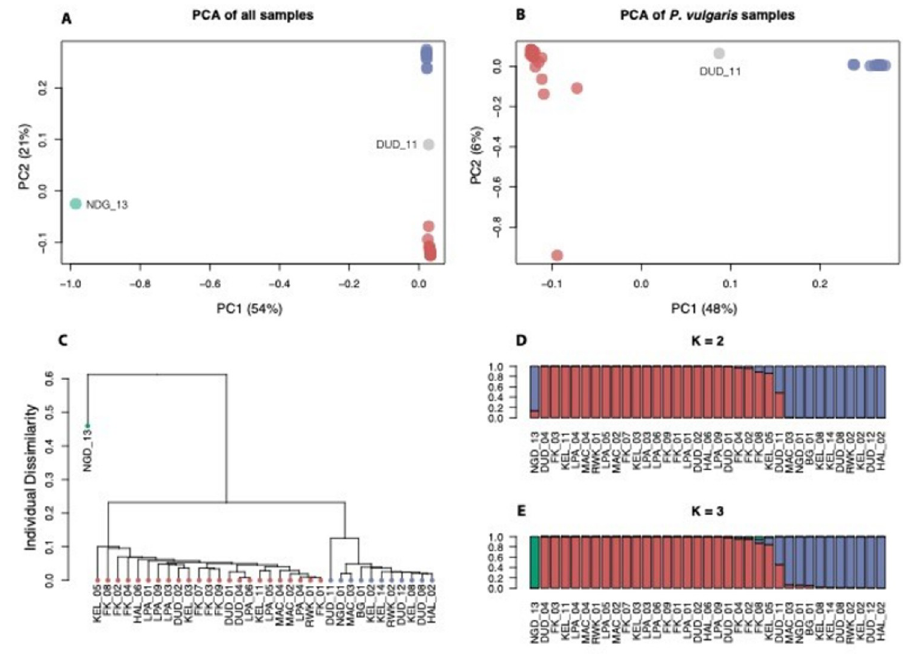
Fig 1. Genetic analyses of 34 P . vulgaris accessions and one P . coccineus accession (NGD_13). A. Principal component analyses on all individuals. B. Principal component analyses on the P . vulgaris individuals. C. Cluster analysis on all individuals. D. STRUCTURE plot for K = 2. E. STRUCTURE plot for K = 3. 218. Red and blue colors correspond to inferred Mesoamerican and Andean accessions, respectively.